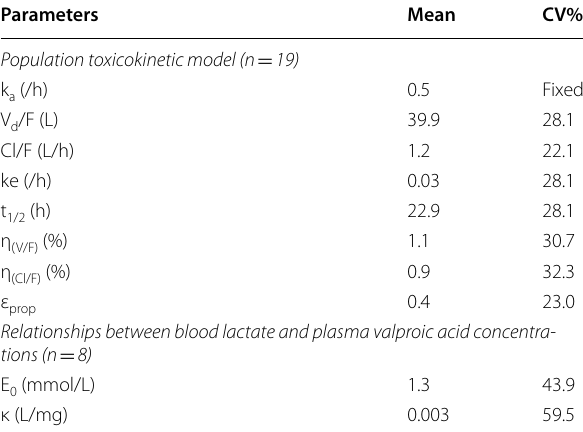
Table 2 Parameters of the population toxicokinetic model of plasma valproic acid and parameters of the model of plasma valproic acid/blood lactate concentration relationships in valproic acid-poisoned patients managed in the intensive care